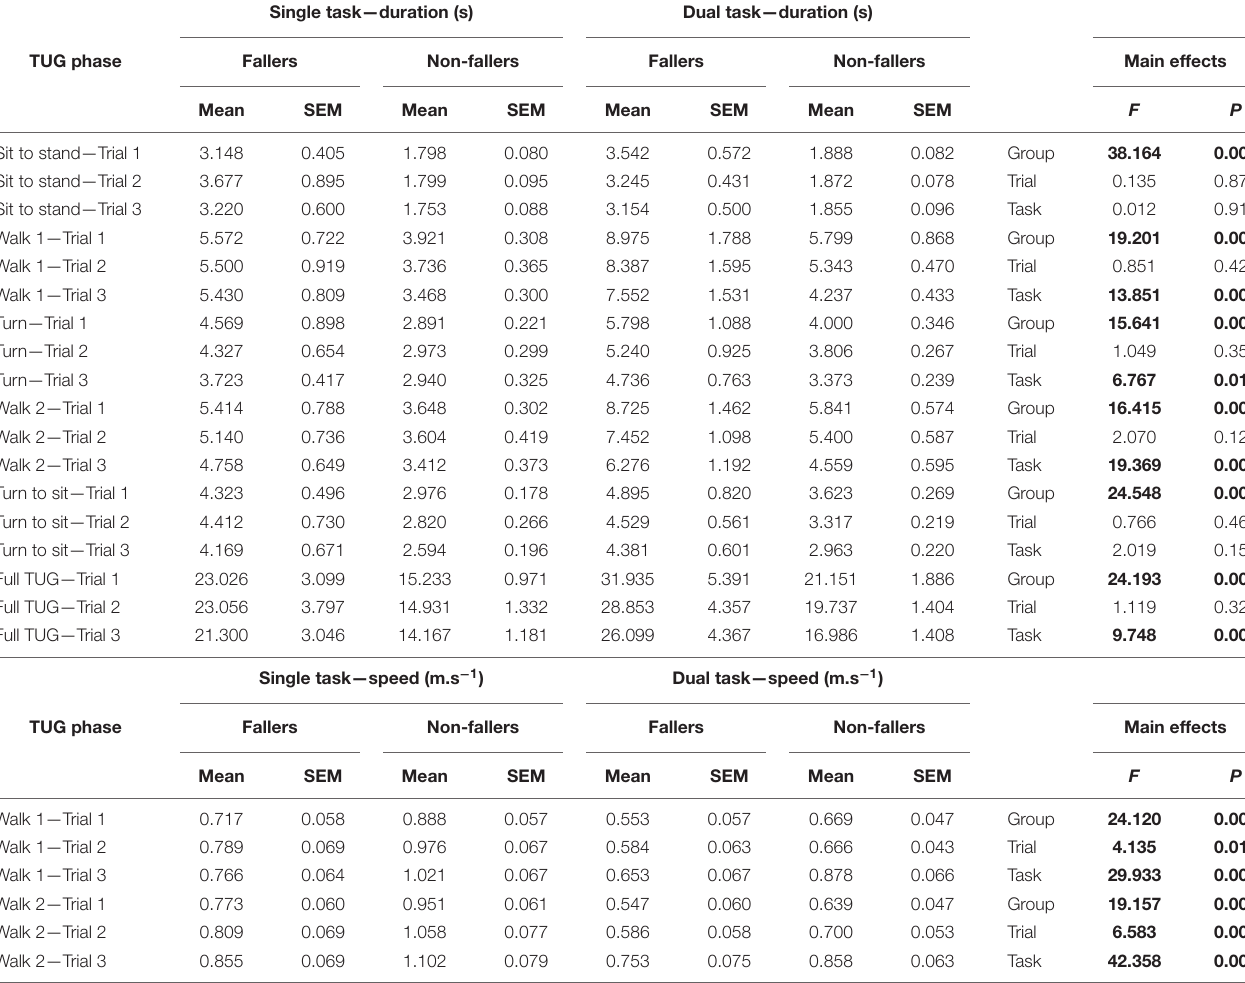
TABLE 2 | Duration and speed in the single and dual-task TUG tests. Single task—duration (s) Dual task—duration (s)